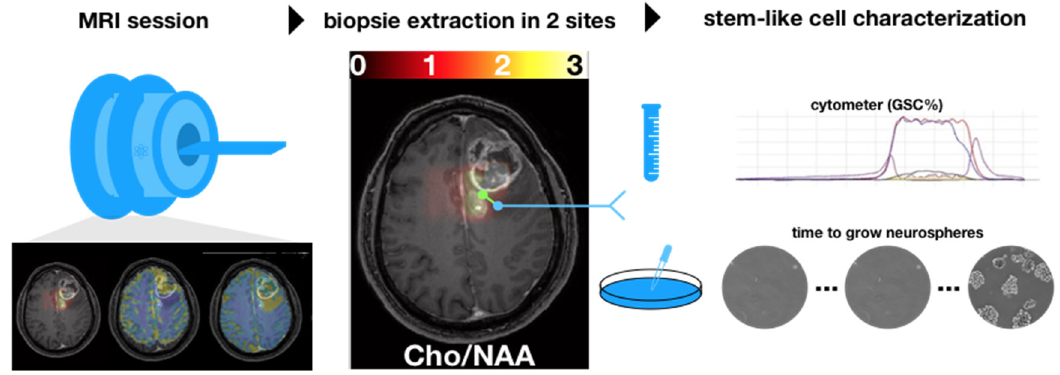
Figure 1. A multimodal MRI session was prescribed up to one week before the surgery. During the surgery, two biopsies were extracted in the hyperintensities-FLAIR region based on the ratio cho/NAA (CNI) (threshold set to 2). Each biopsy was characterized by using a cytometer and by cultivating stem-like cells.